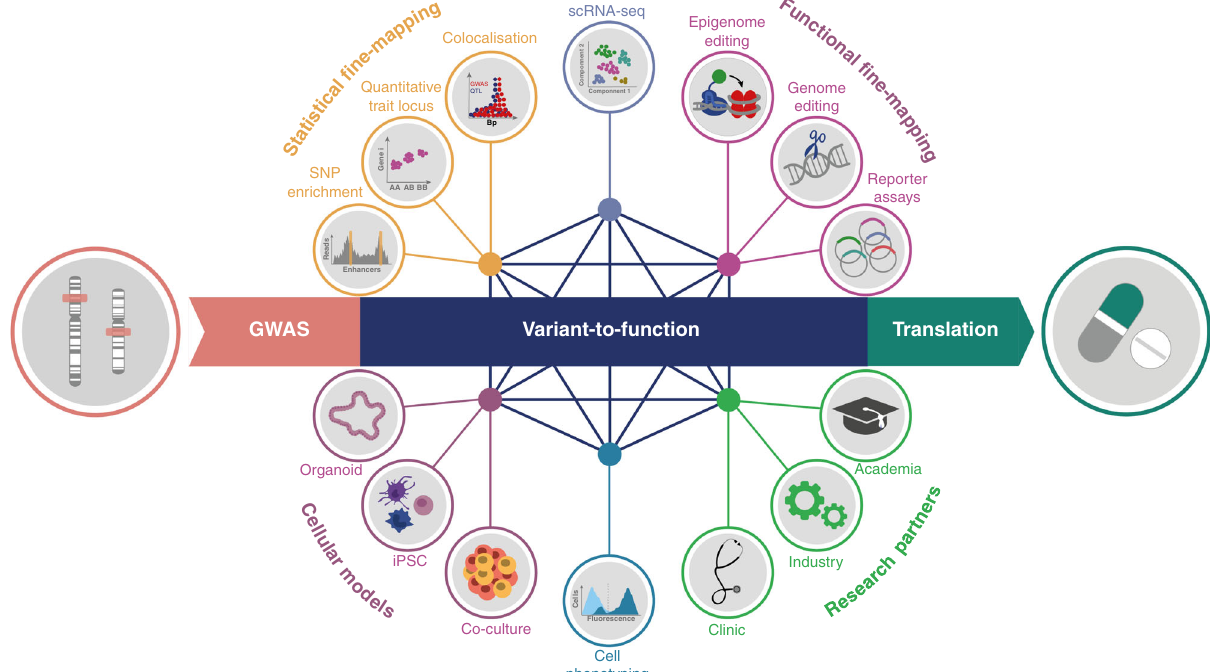
Fig. 1 Variant-to-function approaches for the interpretation of genome-wide association studies (GWAS) signals. Meaningful interpretation of GWAS signals is rapidly advancing as available genomic tools become more sophisticated and the disease cellular models more relevant. Combining different approaches and closer cross-disciplinary collaborations strongly position the community to deliver signi fi cant advancement in biological, clinical and therapeutic insights from GWAS variants in the next